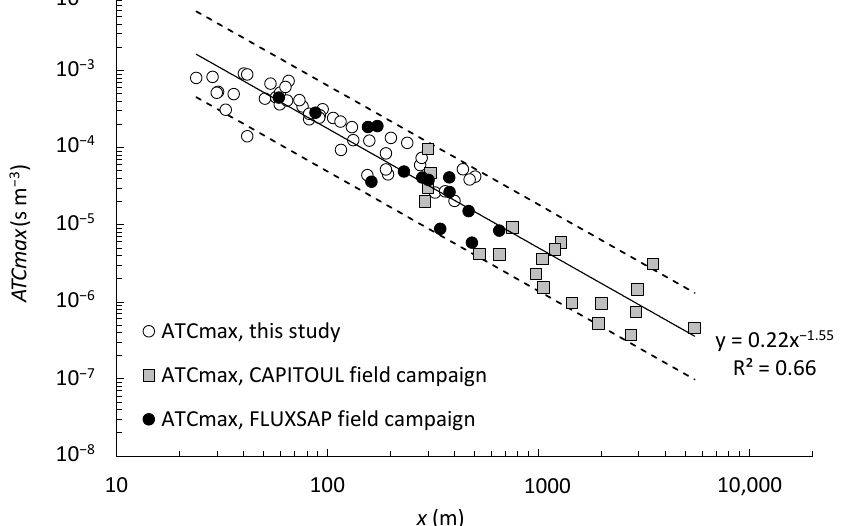
Figure 9. Maximum atmospheric transfer coefficients ATC max measured near to the ground as a function of distance x from the discharge point for Pasquill–Turner atmospheric stability classes A to C; comparison with data from CAPITOUL [2] and FLUXSAP [3] campaigns; the dashed lines indicate the 95% confidence interval defined based on all data.